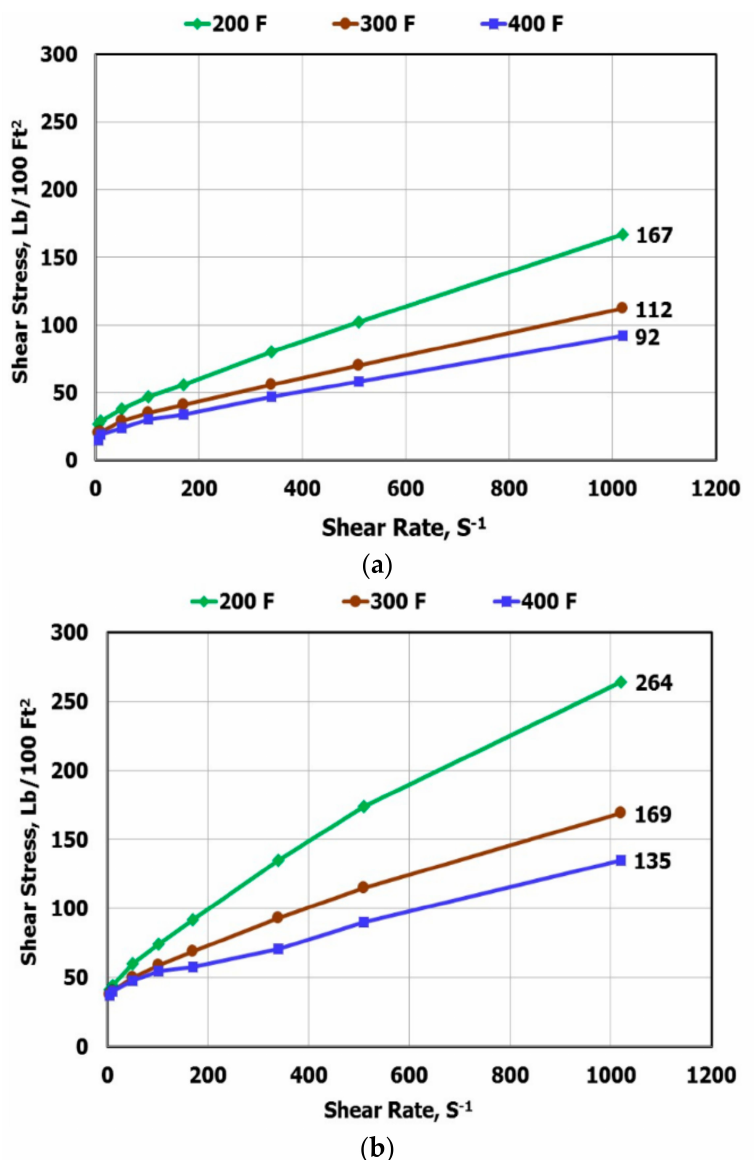
Figure 8. Effect of temperature on shear stress versus shear rate relationship at a different temperature: ( a ) base fluid and ( b ) base fluid with